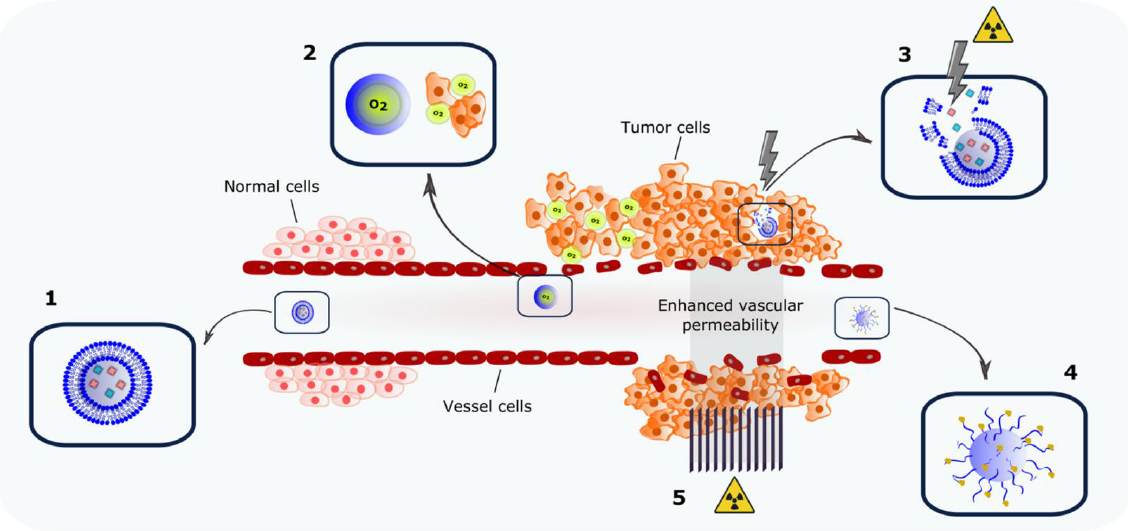
Figure 2. Strategies for combining nanocarrier-assisted delivery of molecules and radiotherapy. Encapsulation of single or multiple radiosensitizing agents in a nanocarrier ( 1 ); delivery of oxygen to diminish tumor hypoxia ( 2 ); radiation as exogenous triggering stimulus for in situ compound release ( 3 ); antigen-capturing nanocarriers to boost the abscopal effect; and ( 4 ) induction of transient enhanced vascular permeability by micro- and mini-beam irradiation modulating the EPR effect ( 5 ).